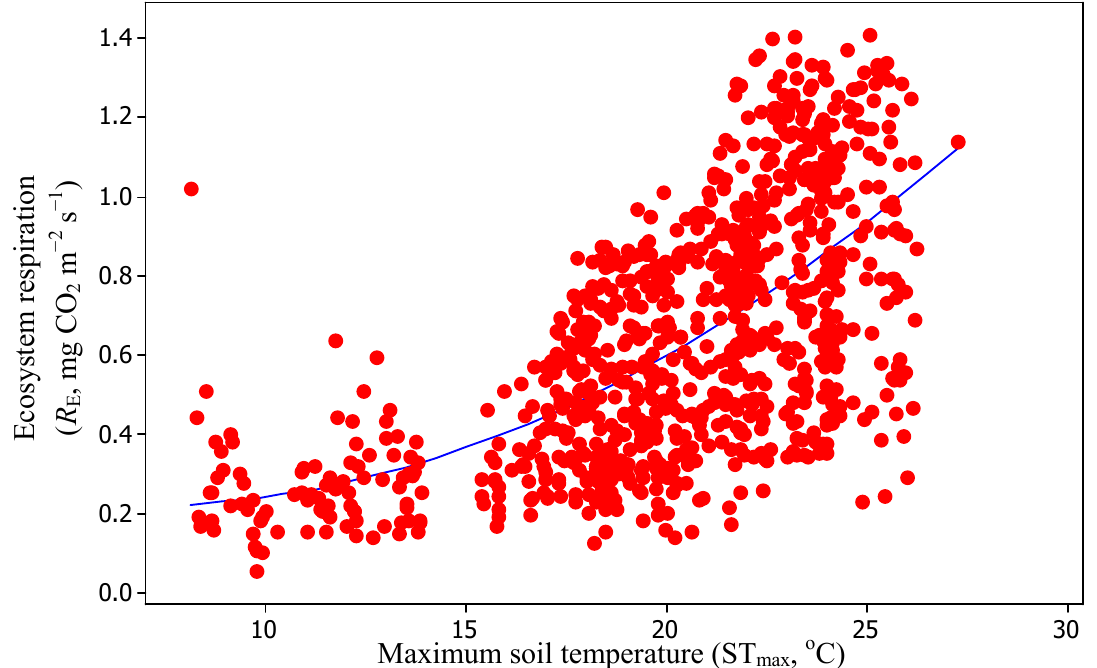
versus daytime R max